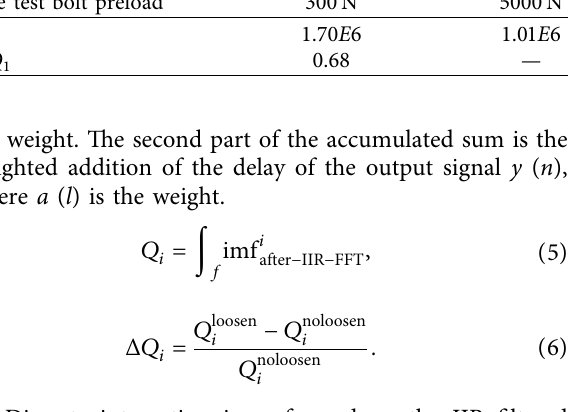
Table 4: Q and Δ Q of the connection structure with 4 bolts under 1 1 1500N impact with standard preload of 5000N and different preload of loose bolt. Table 5: Q and Δ Q of the connection structure with 6 bolts under 1 1 1500N impact load with standard preload of 4500N and loose bolt preload of 300N.